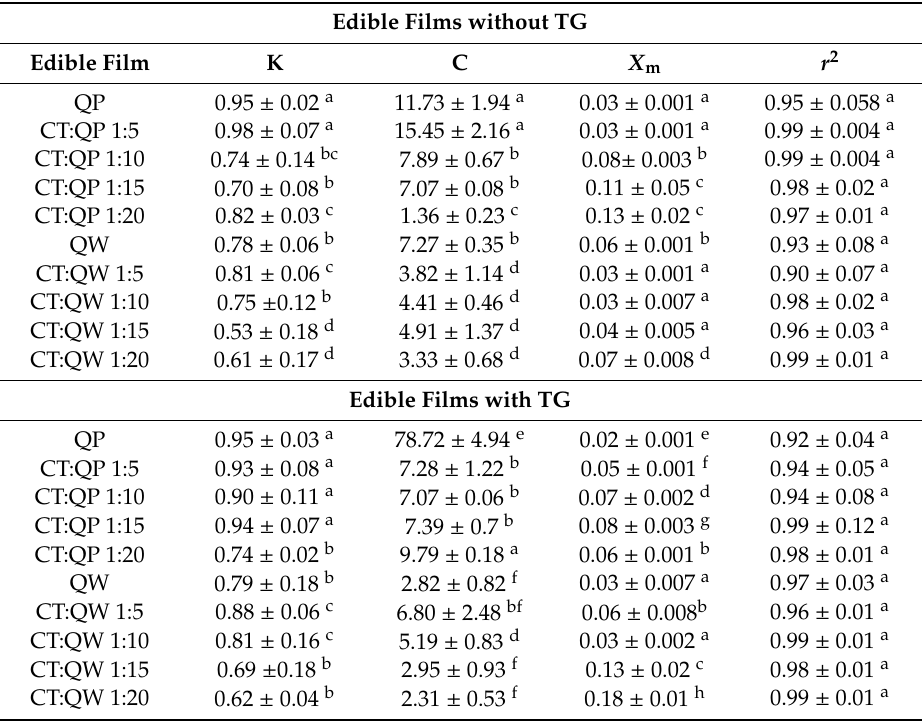
Table 4. Sorption parameters of chitosan-quinoa protein edible films. Edible Films without